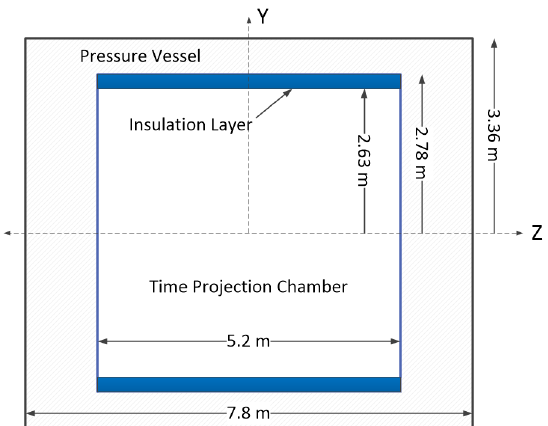
Figure 3. Dimensions of the field cage and pressure